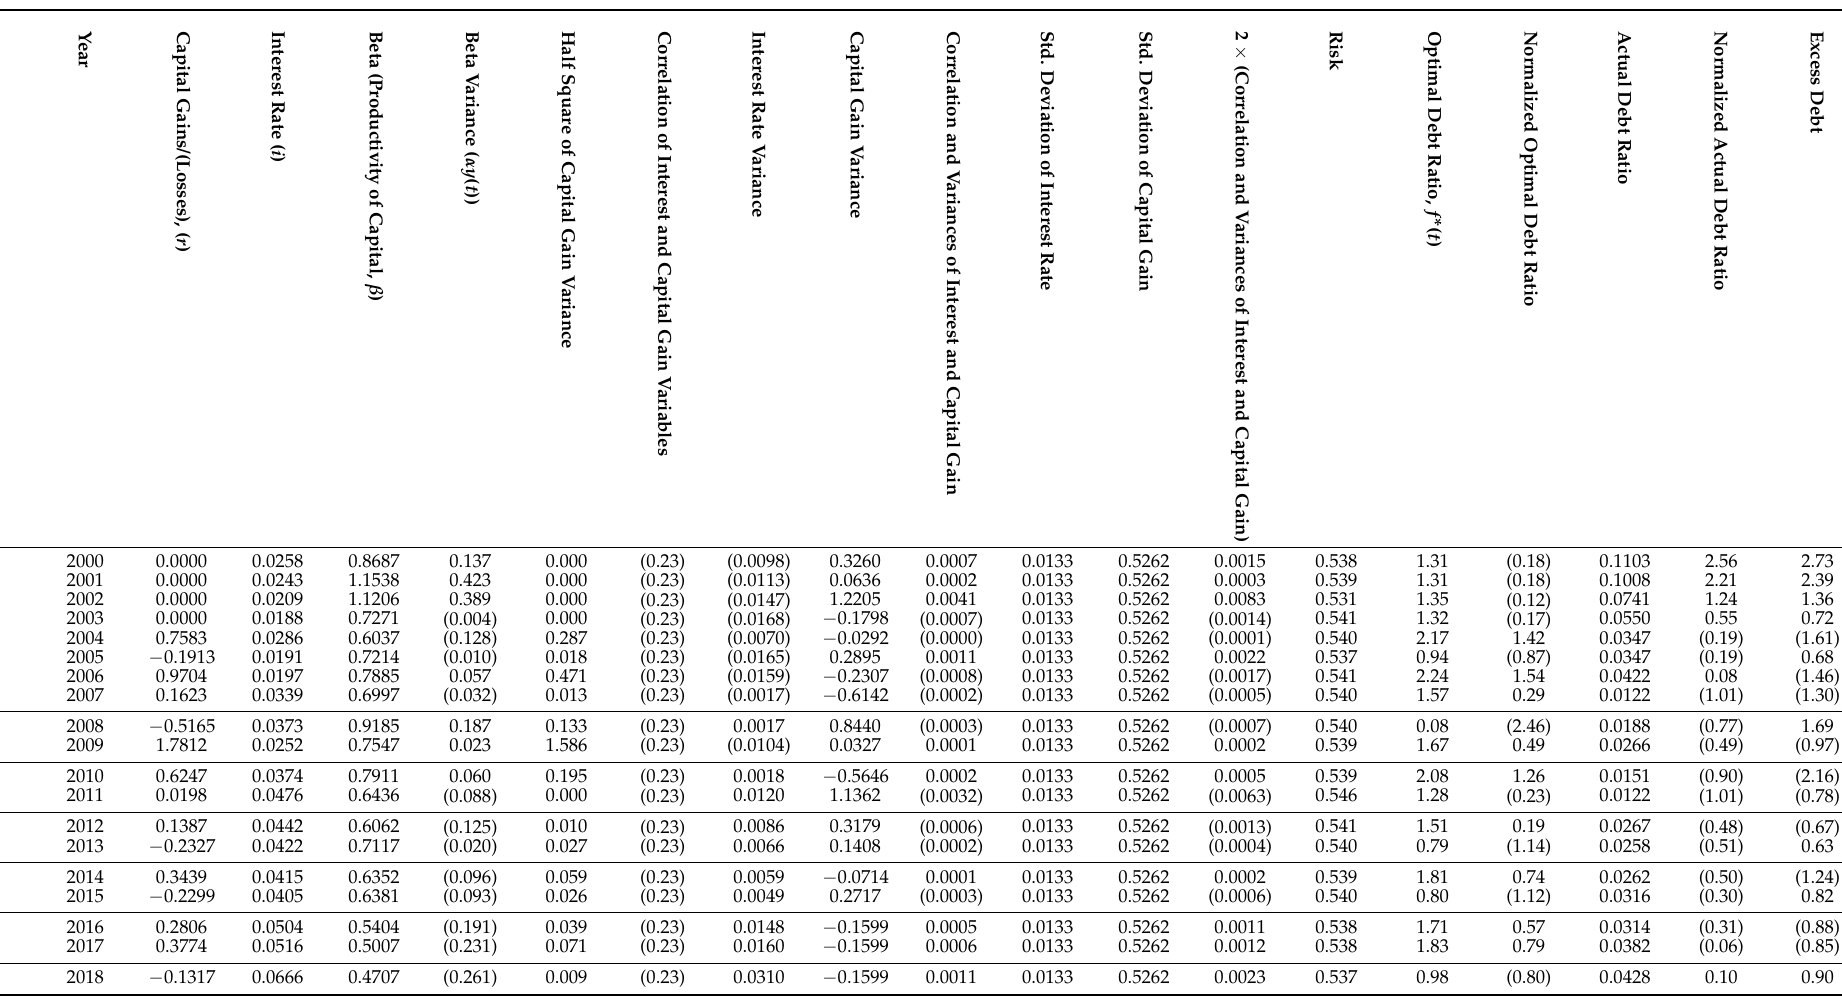
Table A8. Calculations of Optimal and Excess Debt: Bank